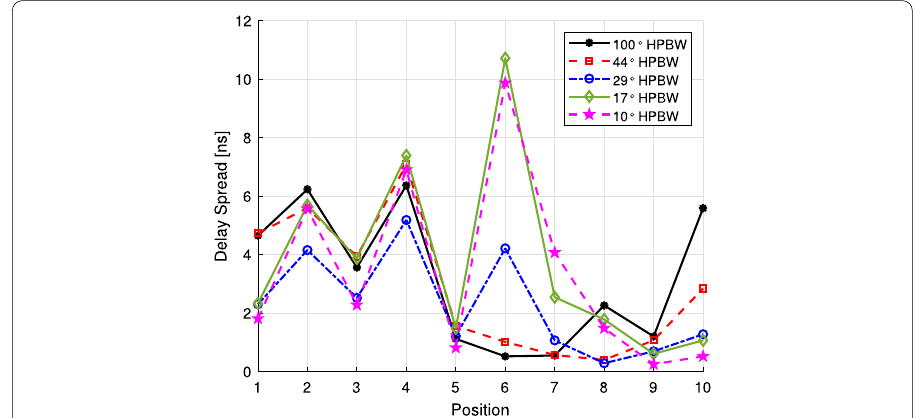
Fig. 12 Root mean square delay spread at receiver positions with different antenna